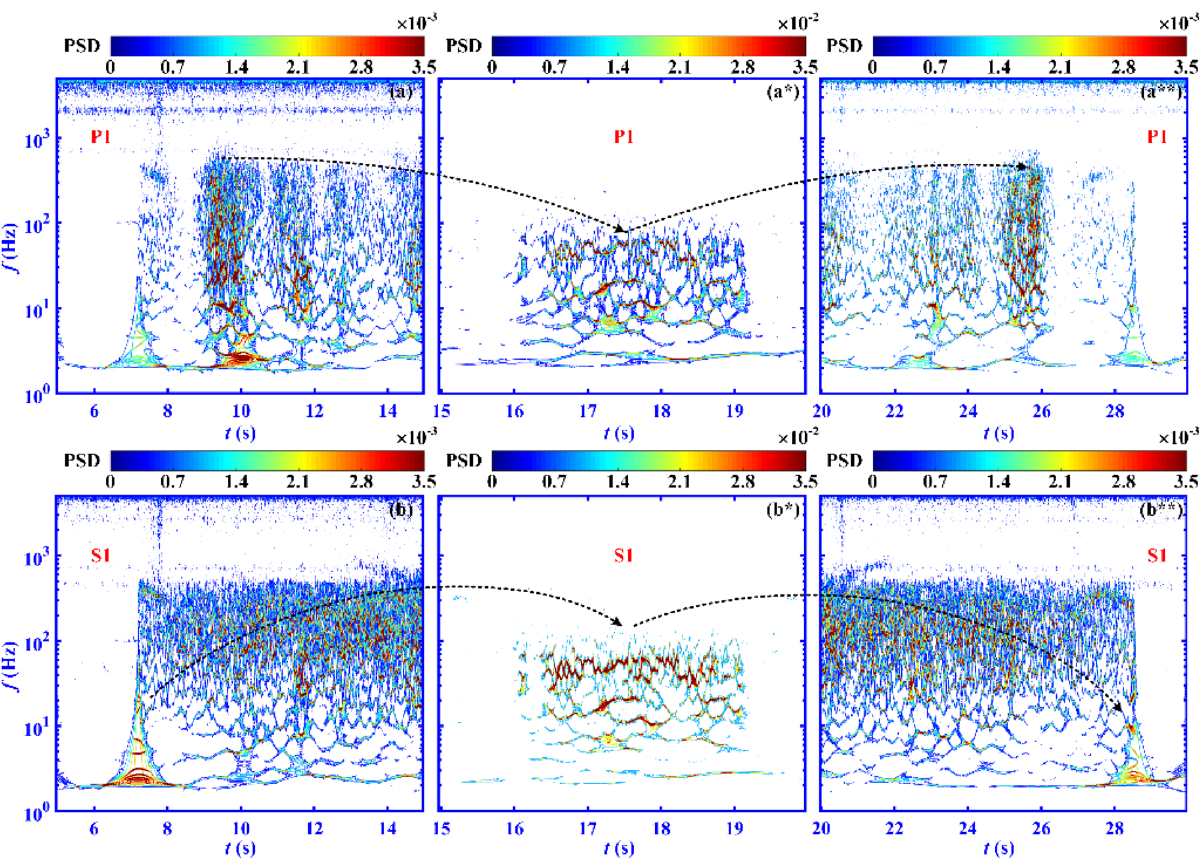
Figure 6. Power spectrum density contours of the pressure signals at P1 and S1 obtained using joint time– frequency analysis over the entire throttling process. Attached and separated flows observed in the pressure signals at ( a ) P1 and ( b ) S1 during the period 5 s < t < 15 s. Separated and oscillatory flows observed in the pressure signals at ( a* ) P1 and ( b* ) S1 during the period 15 s < t < 20 s. Separated and attached flows observed in the pressure signals at ( a** ) P1 and ( b** ) S1 during the period 20 s < t < 30